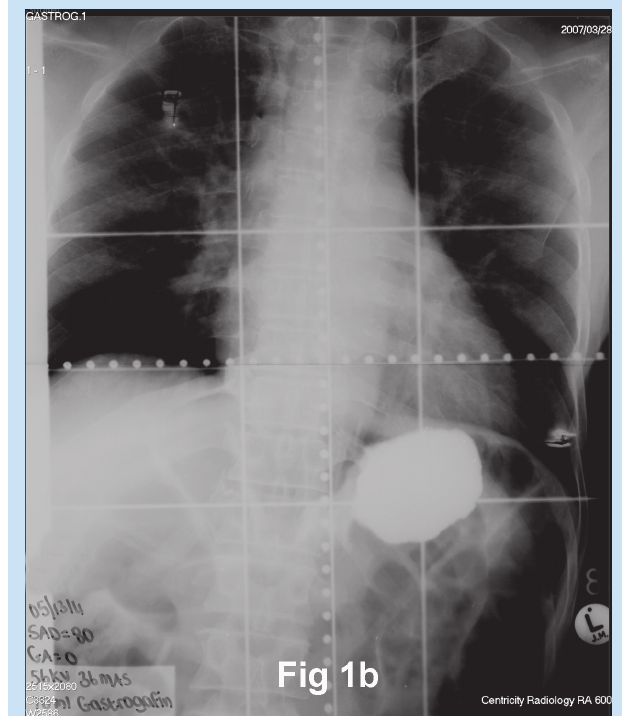
Fig. 1b. Simulator film with gastrograffin as a